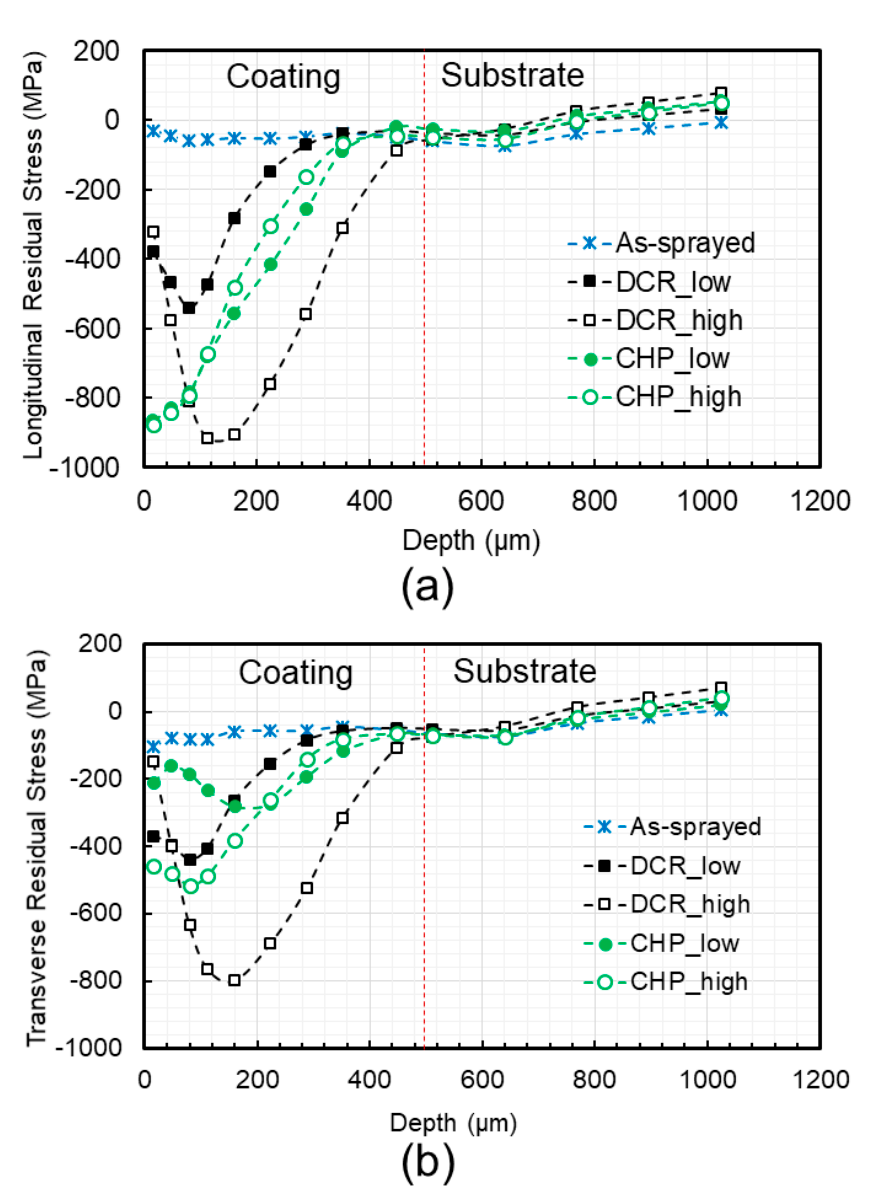
Figure 7. Residual stress profiles along the depth in the ( a ) longitudinal and ( b ) transverse direc ‐ tion.